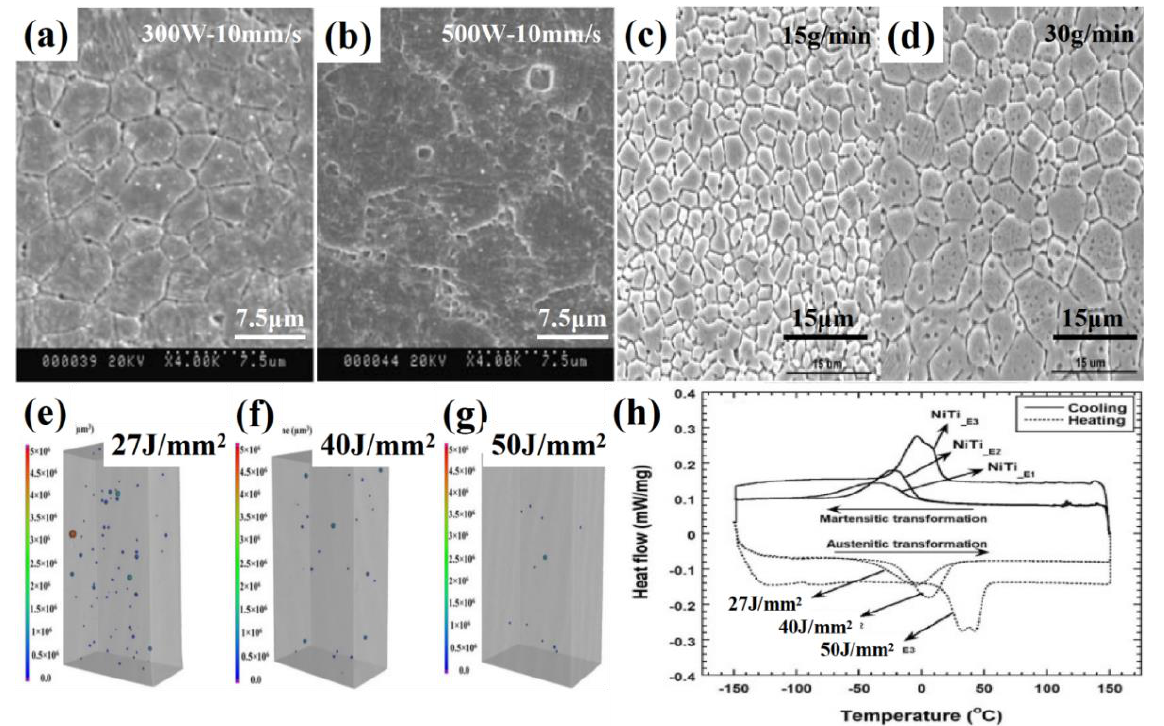
Figure 11. The grain morphology of Ni-Ti alloy formed by LENS under different laser powers: ( a ) 300 W–10 mm/s; ( b ) 500 W–10 mm/s; with different powder feeding rates: ( c ) 15 g/min; ( d ) 30 g/min; ( e – g ) porosity, pore size and ( h ) phase transition temperature of Ni-Ti alloy formed by LENS at different energy densities [33–35].